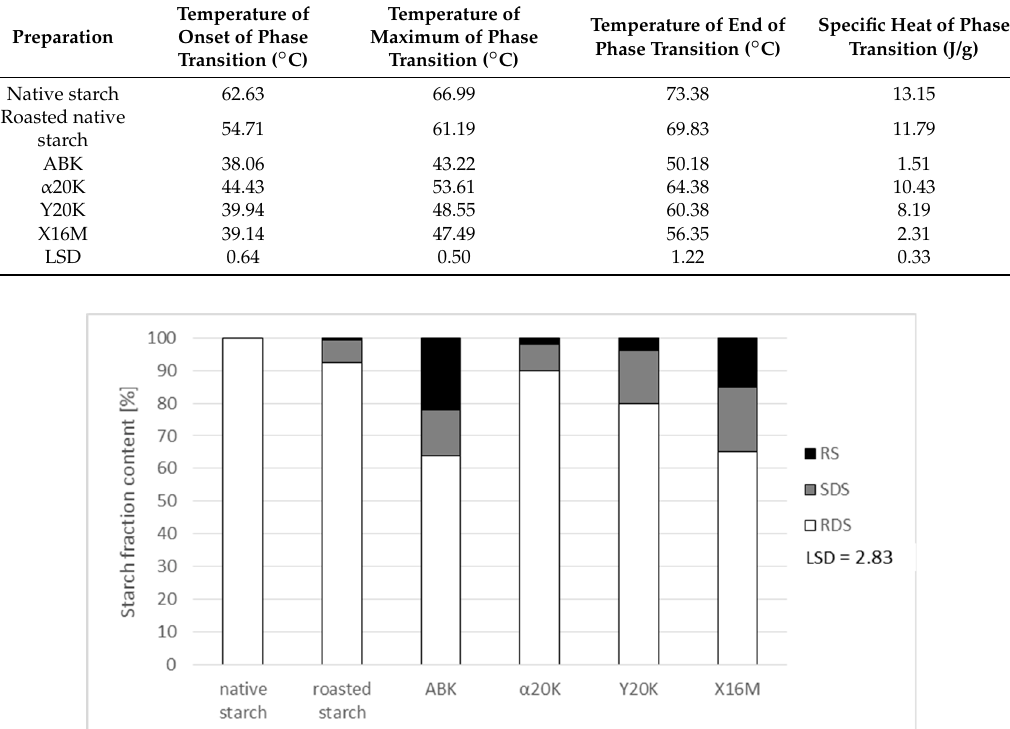
Table 1. Thermal analysis of starch preparations produced with post-culture media.